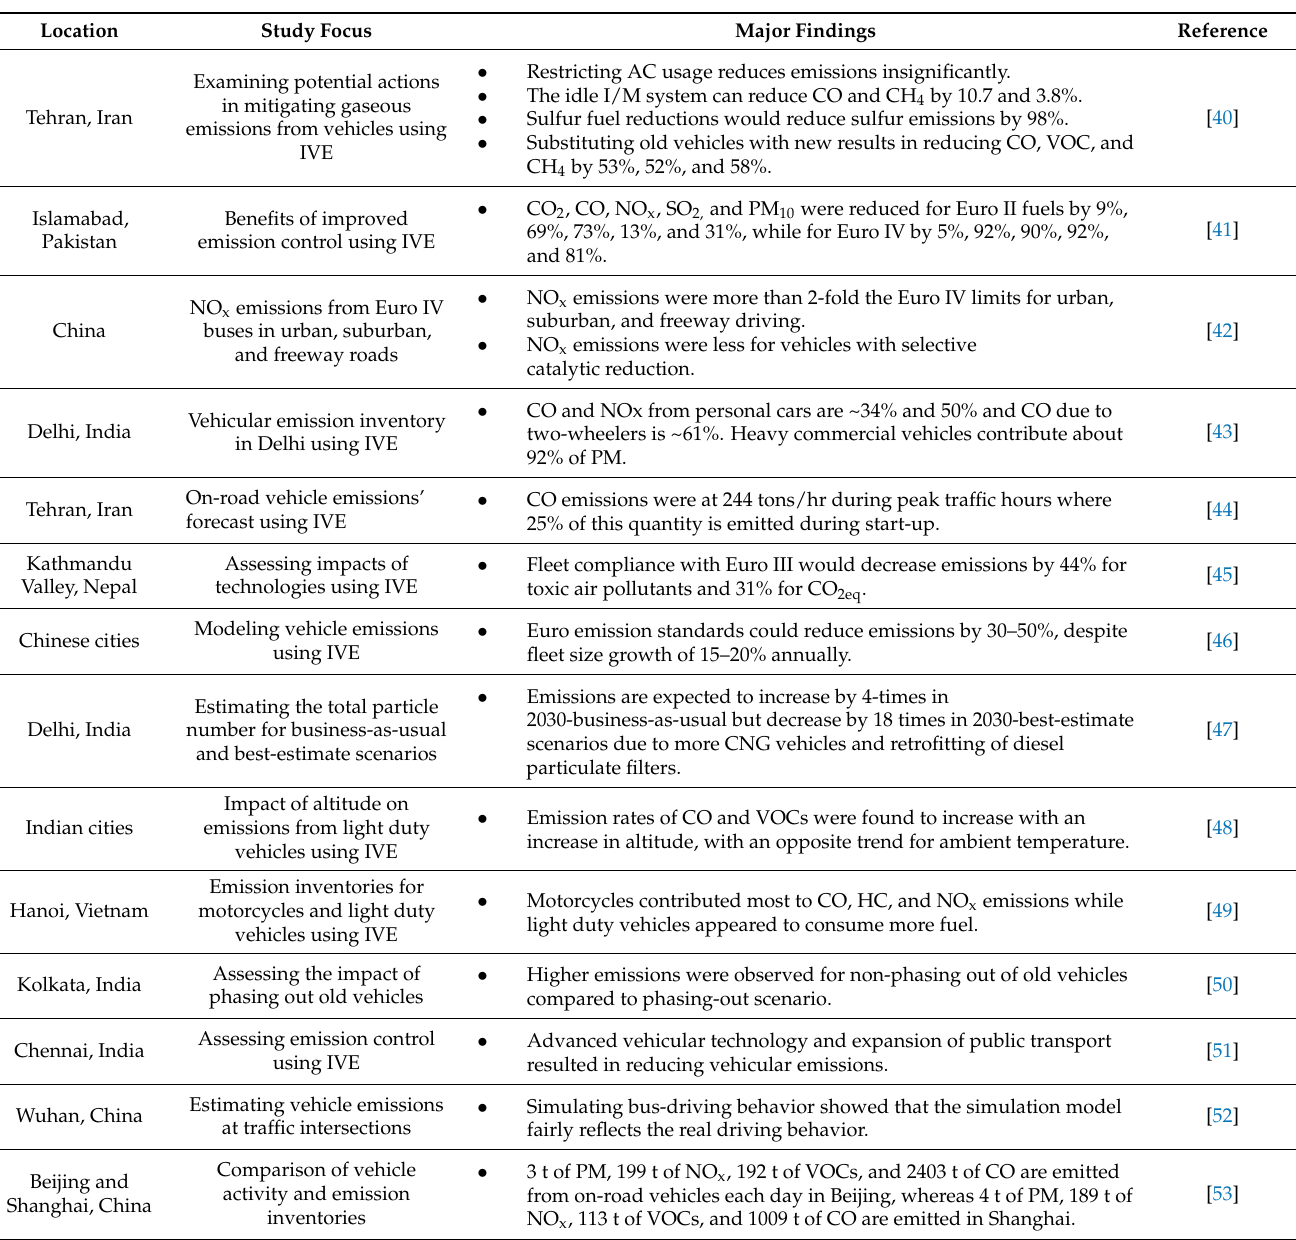
Table 1. Studies that used modeling tools (including IVE) to assess emissions’ control scenarios in cities similar to Greater